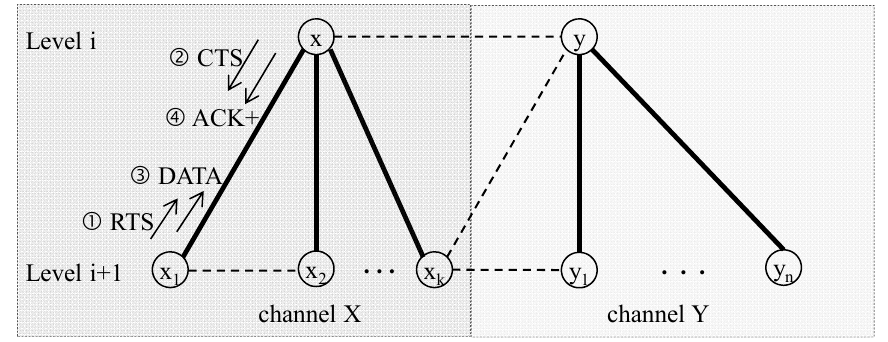
Figure 6. Data transmission sequence within a sharable slot.